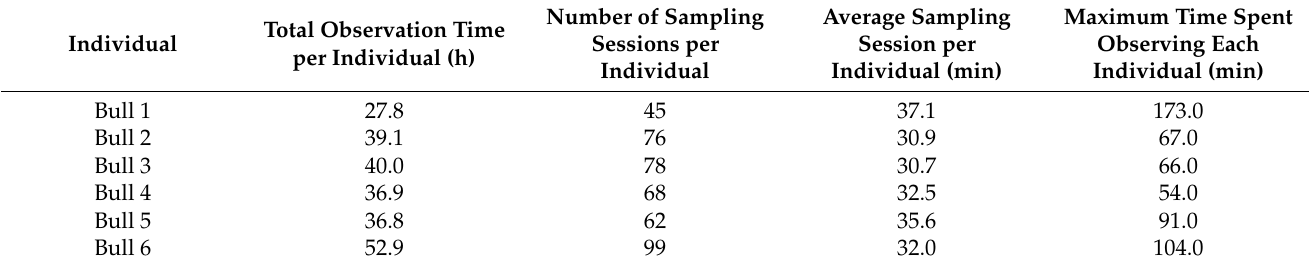
Table 1. Summary statistics regarding behavioural observations. All behavioural observations during the time Bulls 1 and 3 were injured were excluded.